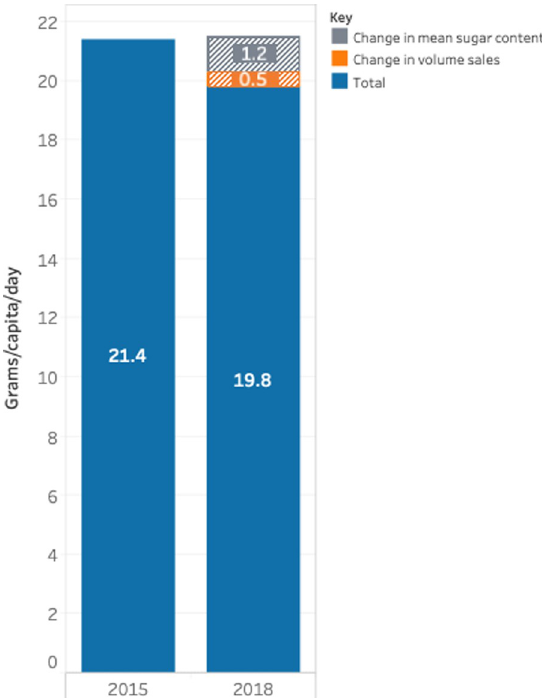
Fig 2. Change in the total volume of sugars from all food categories combined, split by change in sales and change in mean sugar content, 2015 and 2018.